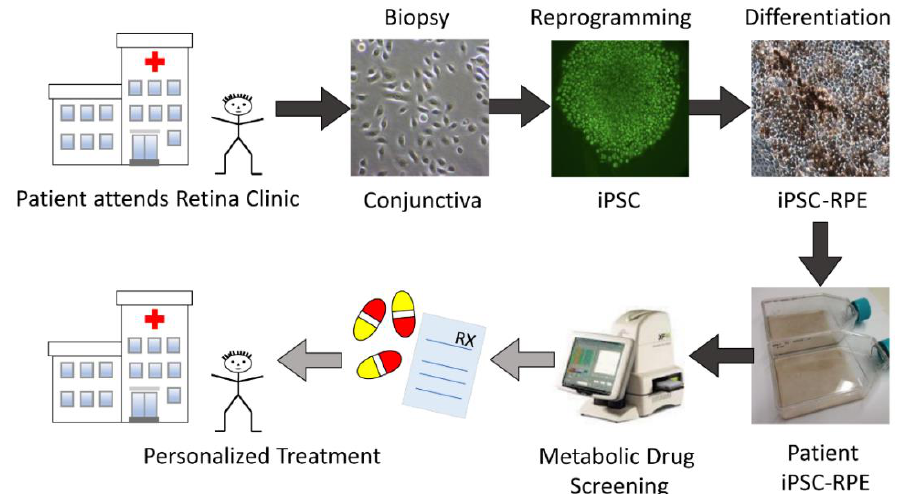
Figure 1. Pathway to precision medicine for patients with age-related macular degeneration. Con- junctival biopsies from patients in the AMD clinic provide somatic cells for patient-specific iPSC- line derivation and differentiation of iPSC-RPE for testing drugs to restore or protect mitochondrial function and provide clinical benefit. Dark gray arrows indicate steps included in the current study. Light gray arrows represent future steps in personalized treatment.